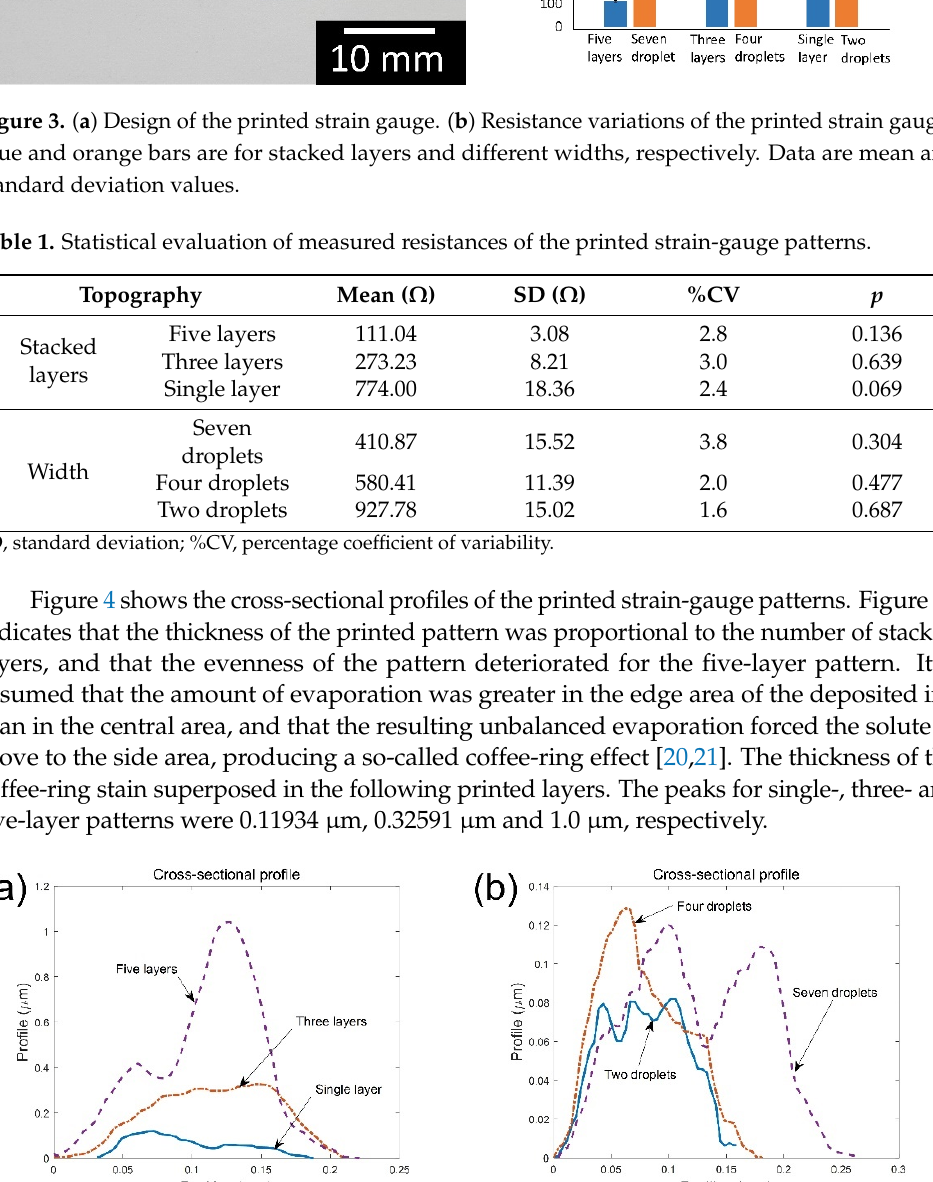
Figure 4. Cross-sectional profiles of printed strain-gauge patterns as a function of ( a ) the number of stacked layers and ( b ) the width. Table 1. Statistical evaluation of measured resistances of the printed strain-gauge patterns.